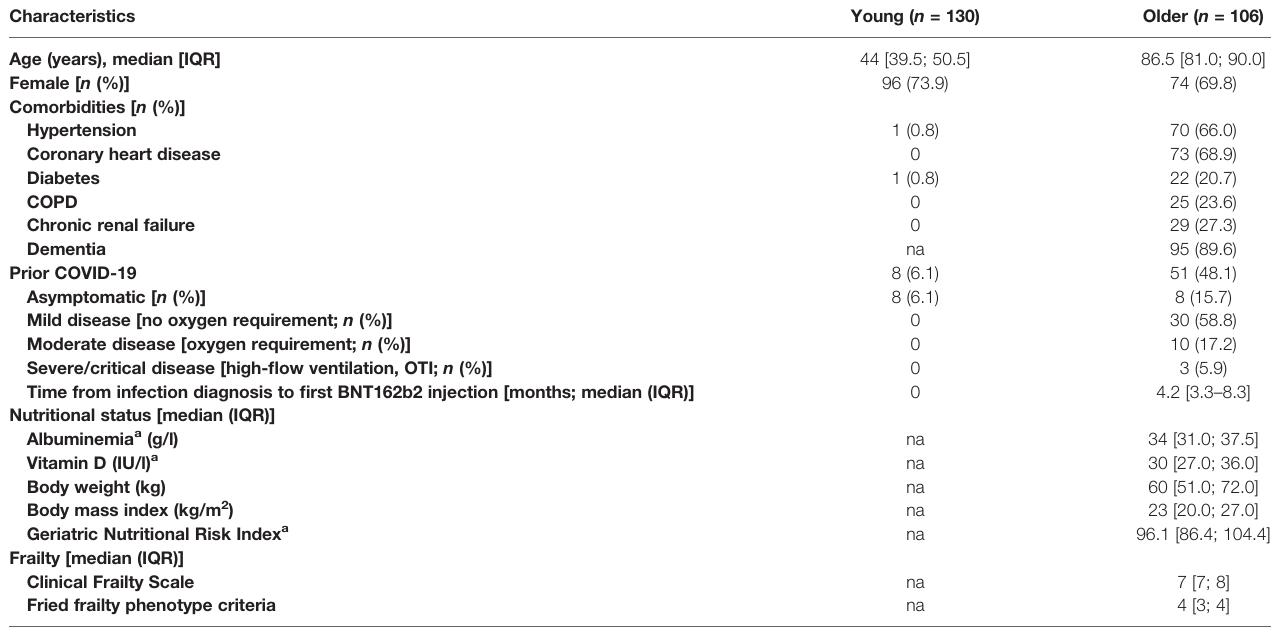
TABLE 1 | Characteristics of healthcare workers (young adults) and long-term care facility residents (older adults) enrolled.